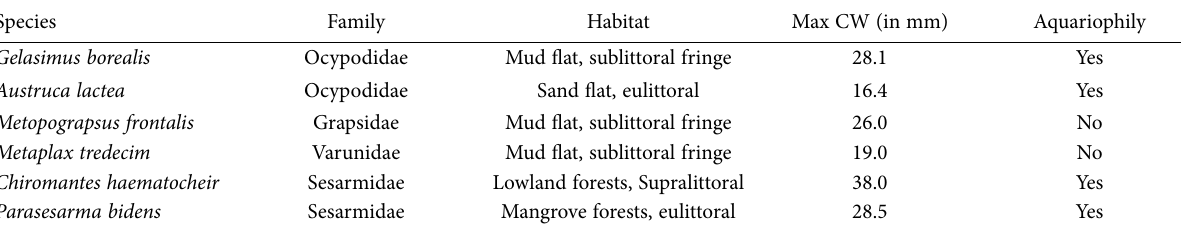
Data shown are: family; mangrove habitat occupied by adult populations (personal data); Max CW, maximum male carapace weight (Aiyun and Siliang 1991); presence in the pet trade for